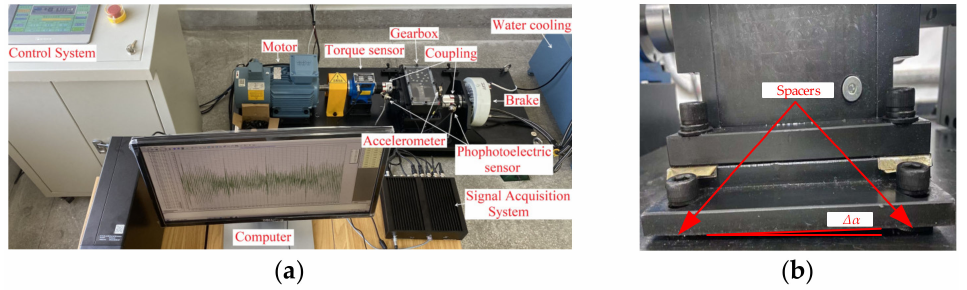
Figure 6. Experimental equipment: ( a ) the bearing-rotor-gear system test bench; ( b ) the rotor misalignment